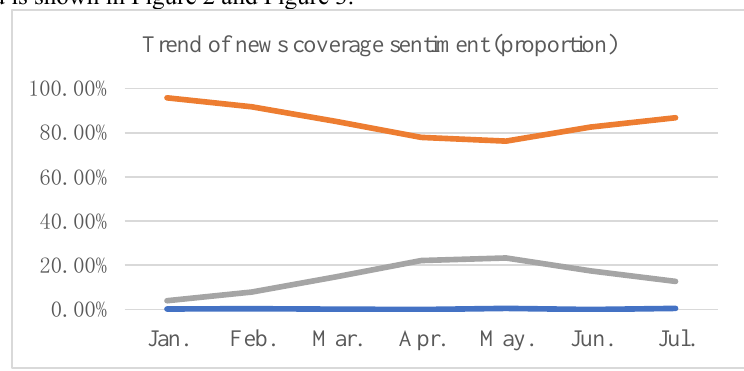
Fig. 2. Trend of news coverage sentiment